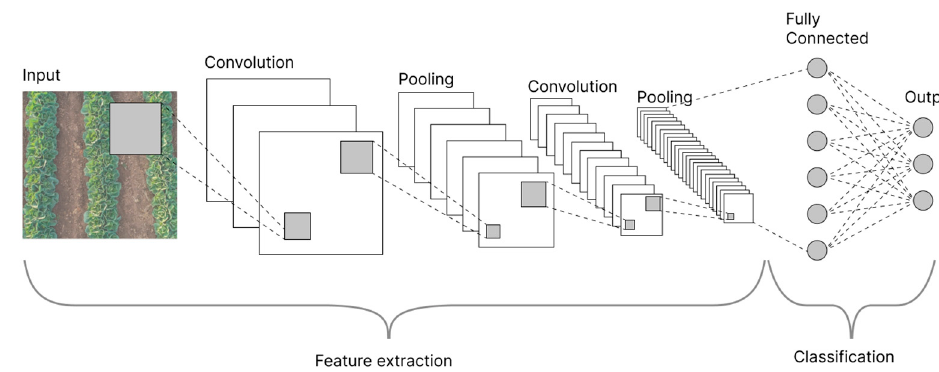
Figure 5. General architecture of a CNN.